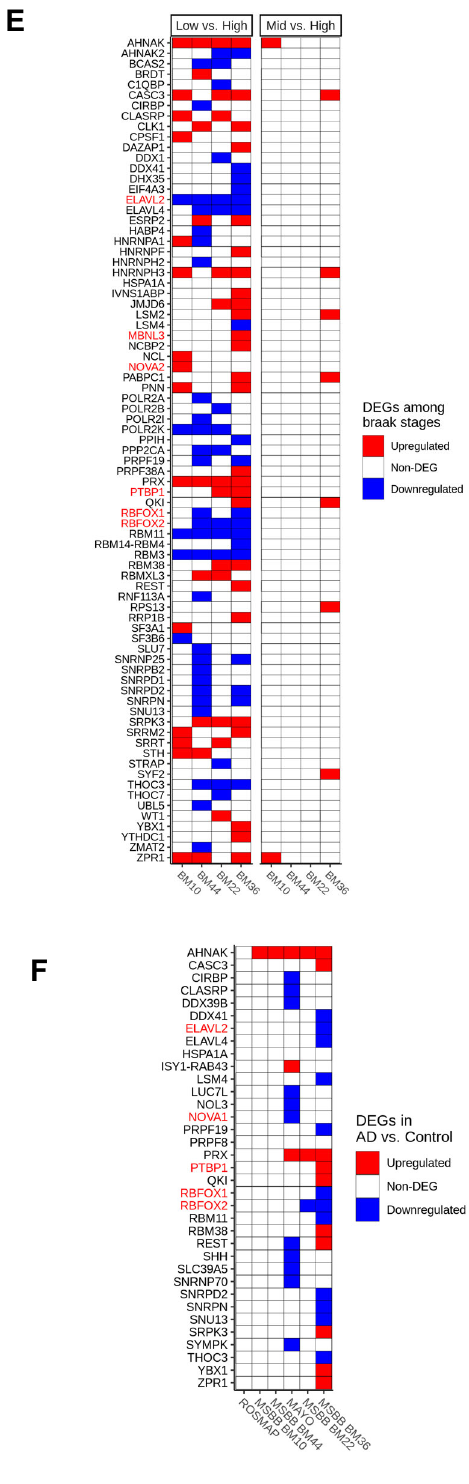
Fig. 6 Coincidence between altered expression of splicing-related genes and gDTUs in advanced pathologic stages of AD. A – D Upset plots showing the total number of gDTU identi fi ed in the comparison between different Braak stages (low vs. high, low vs. mid, and mid vs. high) in BM10 ( A ), BM44 ( B ), BM22 ( C ), or BM36 ( D ). Horizontal bars show the total number of gDTUs identi fi ed in each comparison (low vs. high, low vs. mid, and mid vs. high), whereas vertical bars indicate the gDTUs exclusive or common to different comparisons. Black dots below vertical bars indicate stages analyzed. E , F Differential expression of genes associated with splicing/spliceosome after comparison of different Braak stages ( E ) or AD vs controls in different datasets ( F ). Red and blue squares indicate, respectively, up- and downregulated genes. Gene symbols highlighted in red indicate genes belonging to the neuronal splicing